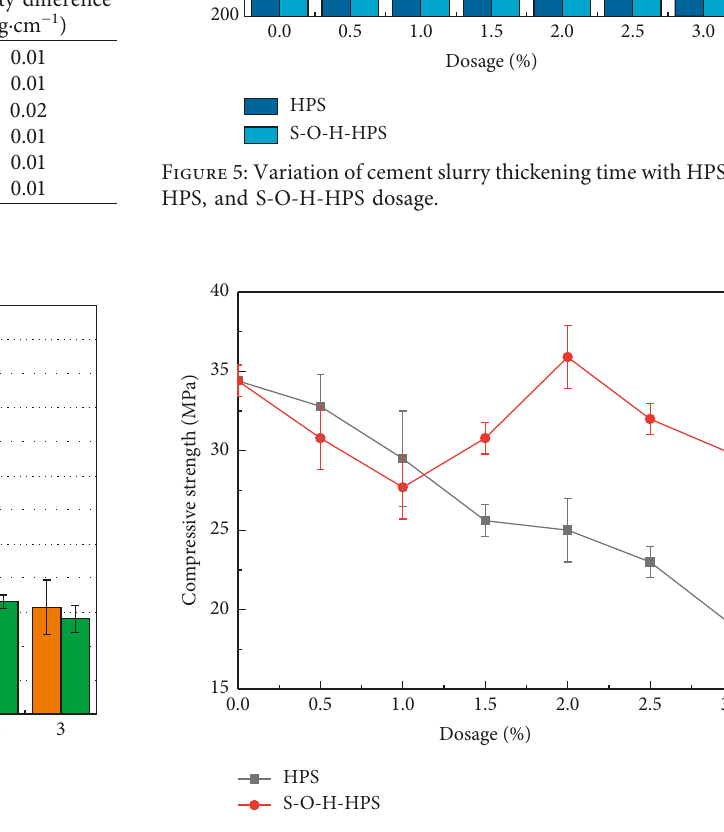
Figure 6: Effect of additives on compressive strength of cement